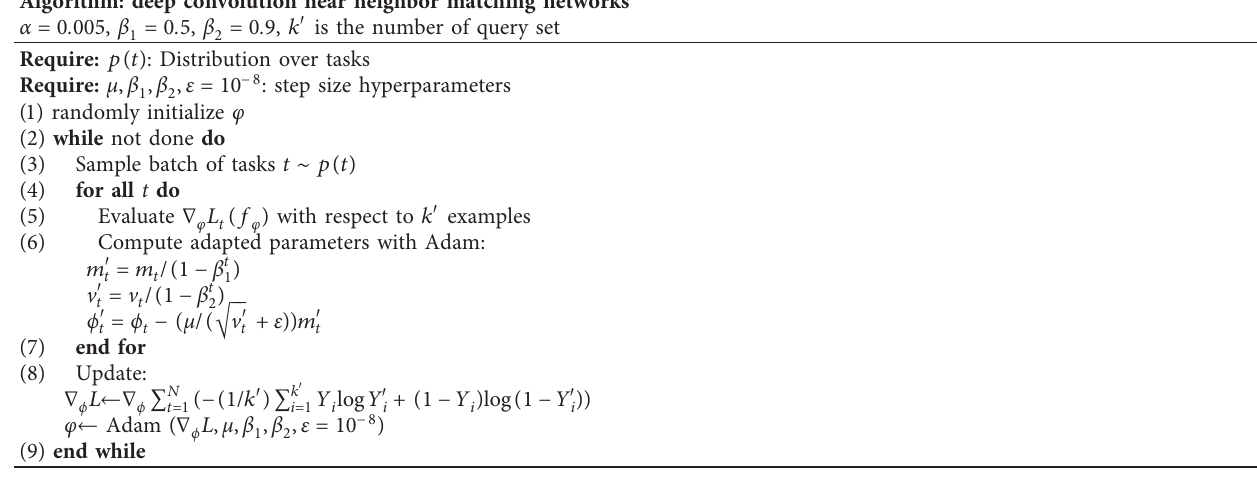
Table 2: Algorithm pseudocode.